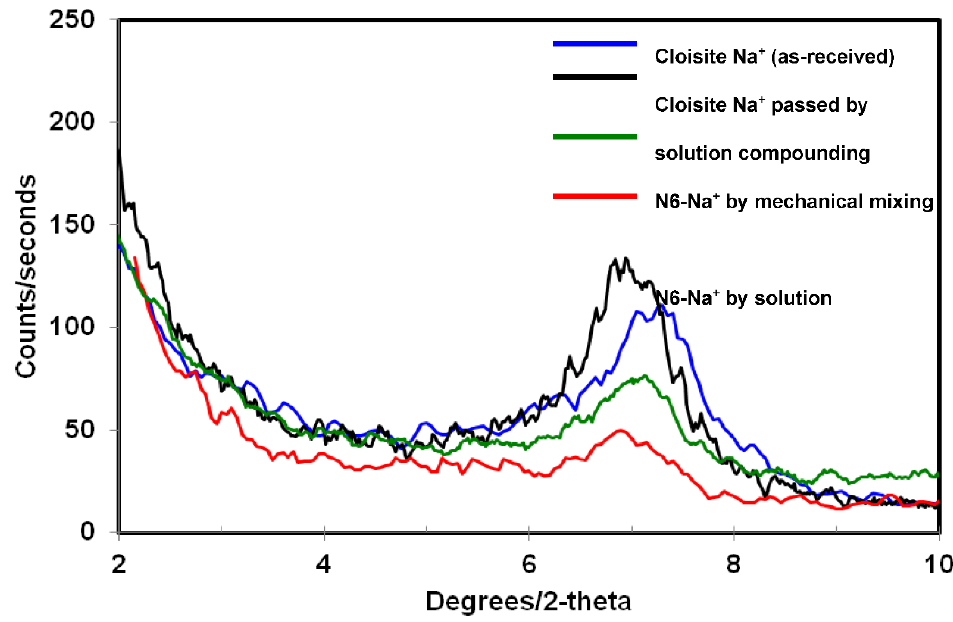
Figure 1. XRD diffraction patterns for the different Na + and Na + composite samples.